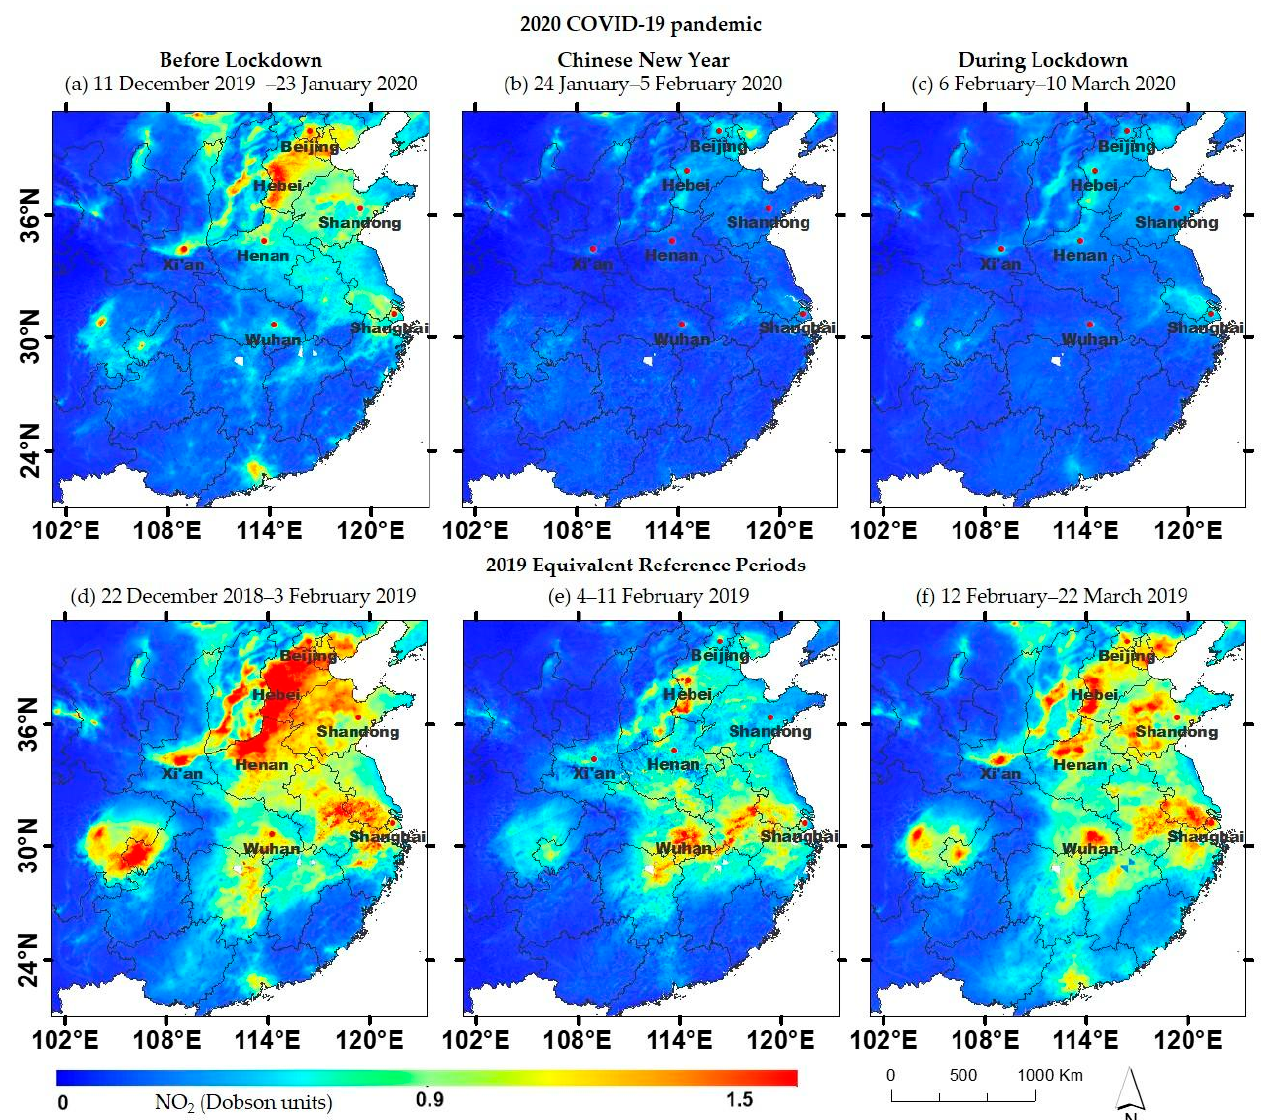
Figure 2. Above: Daily mean satellite-derived tropospheric NO 2 over China in early 2020 for sequential periods ( a ) before lockdown (BLK), ( b ) Chinese New Year (CNY), and ( c ) during lockdown (DLK). Below: Corresponding reference periods of equal duration ( d , e , f , respectively) with respect to the start of the Chinese New Year in 2019.